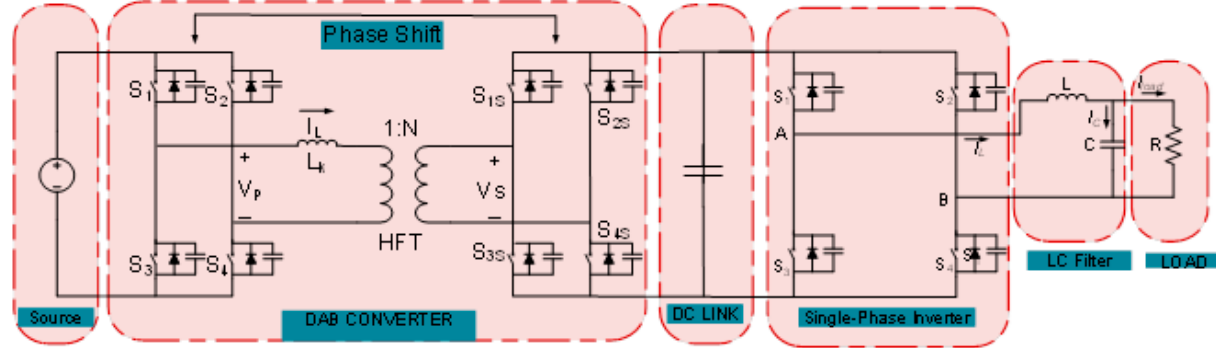
Table 6. Simulated and experimental results [10].